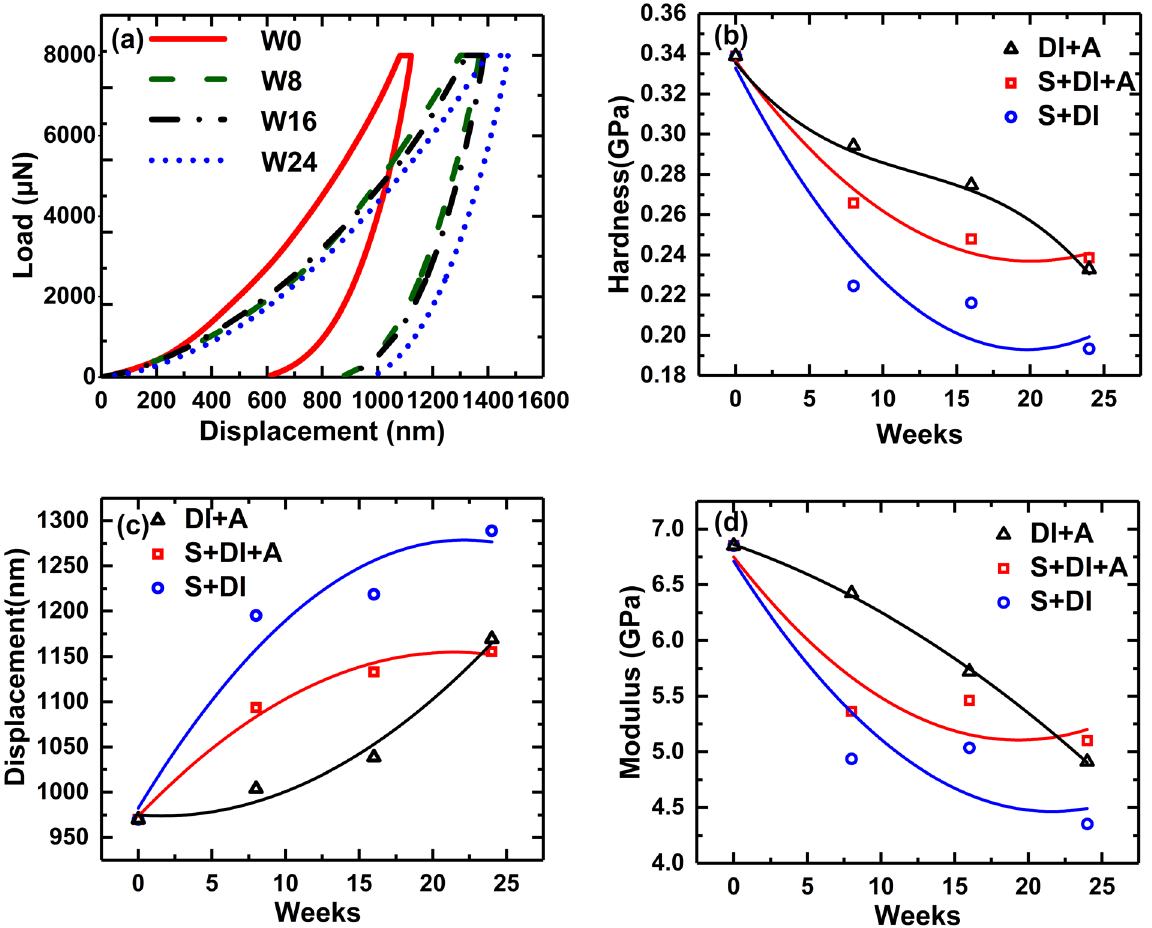
Fig. 4 Nanomechanical characterization of carbon fi ber-reinforced vinyl ester composites in the resin-rich region near the surface. a Load – displacement responses of carbon fi ber-reinforced vinyl ester composites after different exposure time periods in soil solution with deionized water (S + DI) (other load displacement response of samples exposed to autoclaved soil solution with deionized water (S + DI + A) and autoclaved deionized water (DI + A) are displayed in Supplementary Fig. 1). Mechanical responses such as b hardness, c displacement, and d modulus of carbon fi ber-reinforced vinyl ester polymer composites with polynomial fi t as a function of different exposure time periods exposed to different conditions: autoclaved deionized water ( Δ -DI + A), autoclaved soil solution with deionized water ( □ − S + DI + A), and soil solution with deionized water (O-S +